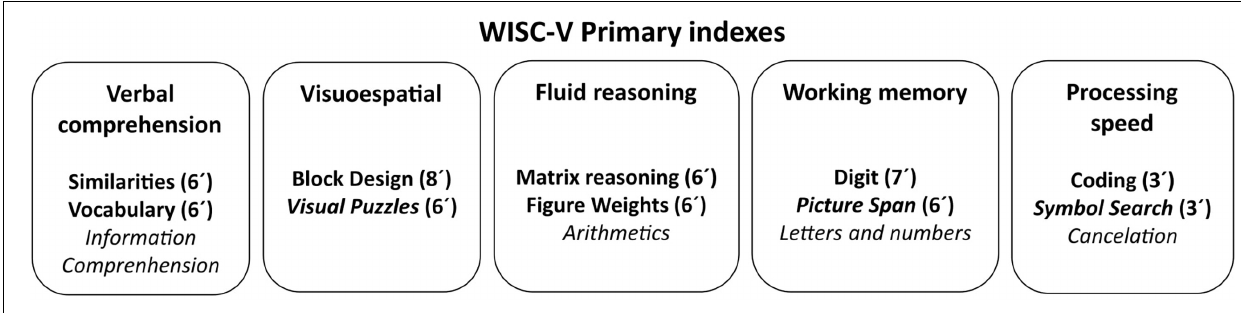
Frontiers in Psychology |